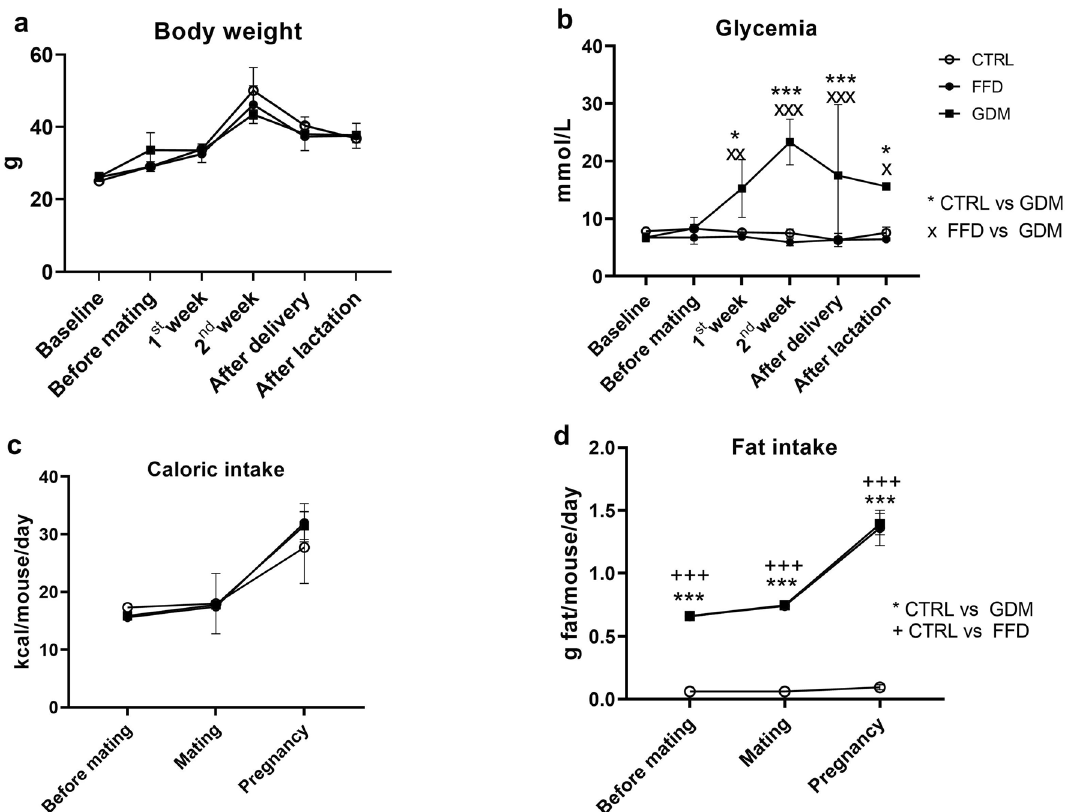
Figure 1. ( a ) Time-course of body weight in dams: p group = 0.808, p time < 0.001, p group*time interaction = 0.107; ( b ) time course of random glycemia in dams: p group = 0.013, p time = 0.045, p group*time interaction < 0.001; ( c ) mean daily caloric intake of dams before mating, during mating and pregnancy: p group = 0.883, p time < 0.001, p group*time interaction = 0.540; ( d ) mean daily fat intake of dams before mating, during mating and pregnancy: p group < 0.001, p time < 0.001, p group*time interaction < 0.001; groups: CTRL dams consuming control diet, FFD dams consuming fast-food diet (cheeseburgers), GDM dams with gestational diabetes mellitus. * ,+ p < 0.05, ** ,++ p < 0.01, *** ,+++ p < The relative weight of the brown adipose tissue (BAT) declined across the three groups in both sexes but significance was reached only for GDM vs. CTRL male offspring (Fig. 3a). Moreover, males displayed significantly lower BAT/body weight than females. Male offspring showed a higher relative weight of the kidneys than females (Fig. 3b). Kidney/body weight was lower in GDM male offspring than in both the CTRL and FFD groups (p < 0.01). Liver cholesterol content showed an increasing trend across the three categories in both sexes, but significance was not reached (Fig. 3c). Females displayed a higher liver content of triacylglycerols (TAG) than males, and in both sexes, the offspring of FFD and GDM dams showed a higher accumulation of TAG than the controls (Fig. 3d). Levels of ecDNA were not affected by maternal intrauterine factors. Neither total plasma ecDNA (Fig. 4a) nor its components—ncDNA (Fig. 4b), mtDNA (Fig. 4c), or the mtDNA-to-ncDNA ratio (Fig. 4d) dif- fered significantly between the offspring groups. Deoxyribonuclease activity was higher in CTRL females than in the FFD group (Fig. 4e; p < 0.05). As short ncDNA and mtDNA fragments could have escaped replication in the PCR assay, ecDNA fragmentation analysis was performed on pooled DNA samples from the offspring of each dam. Specific fragments of a certain length were not revealed (Supplementary Fig. S1). GDM offspring displayed the lowest IL‑1α concentrations. Circulating levels of pro- and anti- inflammatory markers are given in Fig. 5a–i. IL-1α concentrations were lower in the GDM female offspring than in both other groups; these concentrations were also lower in GDM males than in FFD males (Fig. 5a). In females, the CTRL group displayed higher IL-17A concentrations than the FFD group (Fig. 5c; p < 0.01). Among males, IL-23 levels were higher in the offspring of the CTRL dams than in FFD and GDM counterparts (Fig. 5d; p < 0.01; both). INF-β concentrations were higher in CTRL offspring, than in both other groups in females and vs. the offspring of FFD dams in males (Fig. 5i; p < 0.05; all). No significant effect of sex or the group*sex interac- tion was revealed for either variable.